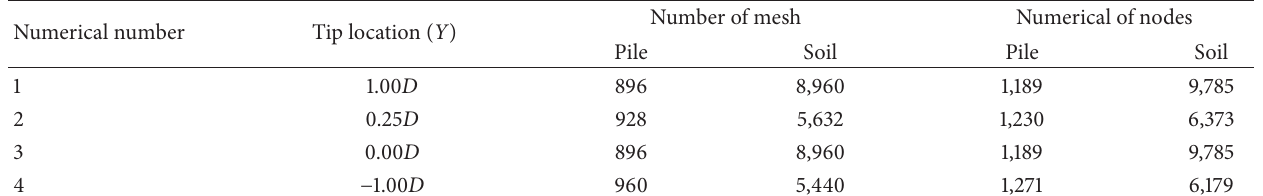
Figure 2: Finite element meshes adopted for: (a) the three-dimensional pile-soil system; (b) the cross-section. Table 1: Summary of the elements and nodes in the numerical analyses.